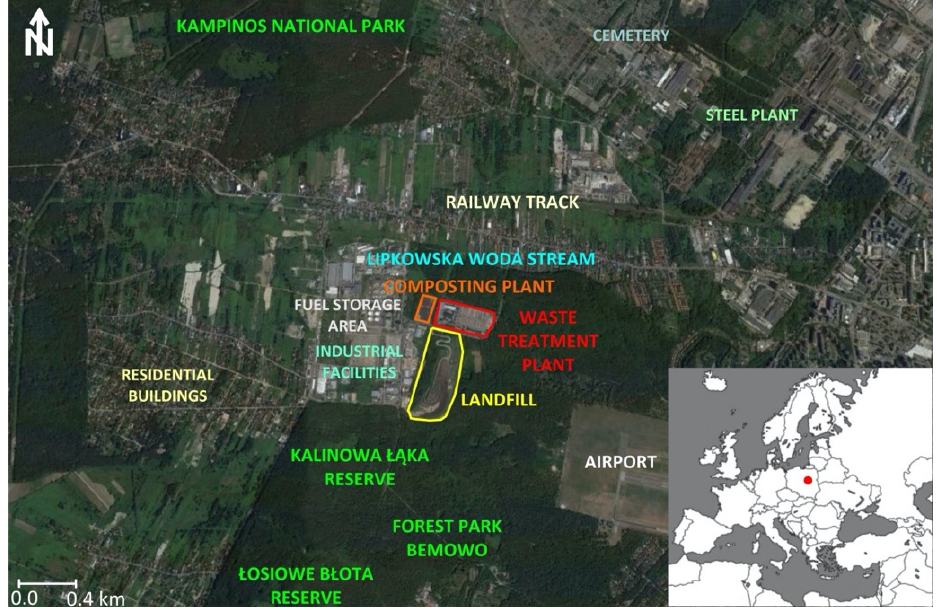
Figure 2. The study area concerning the surrounding infrastructure.